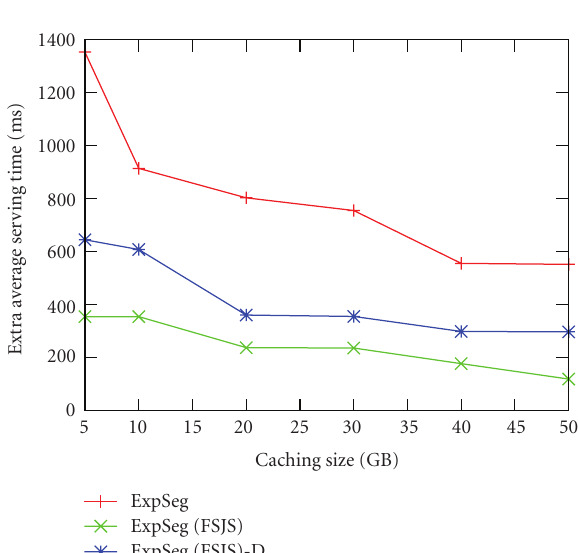
Figure 9: Prefix/BaseSegment =